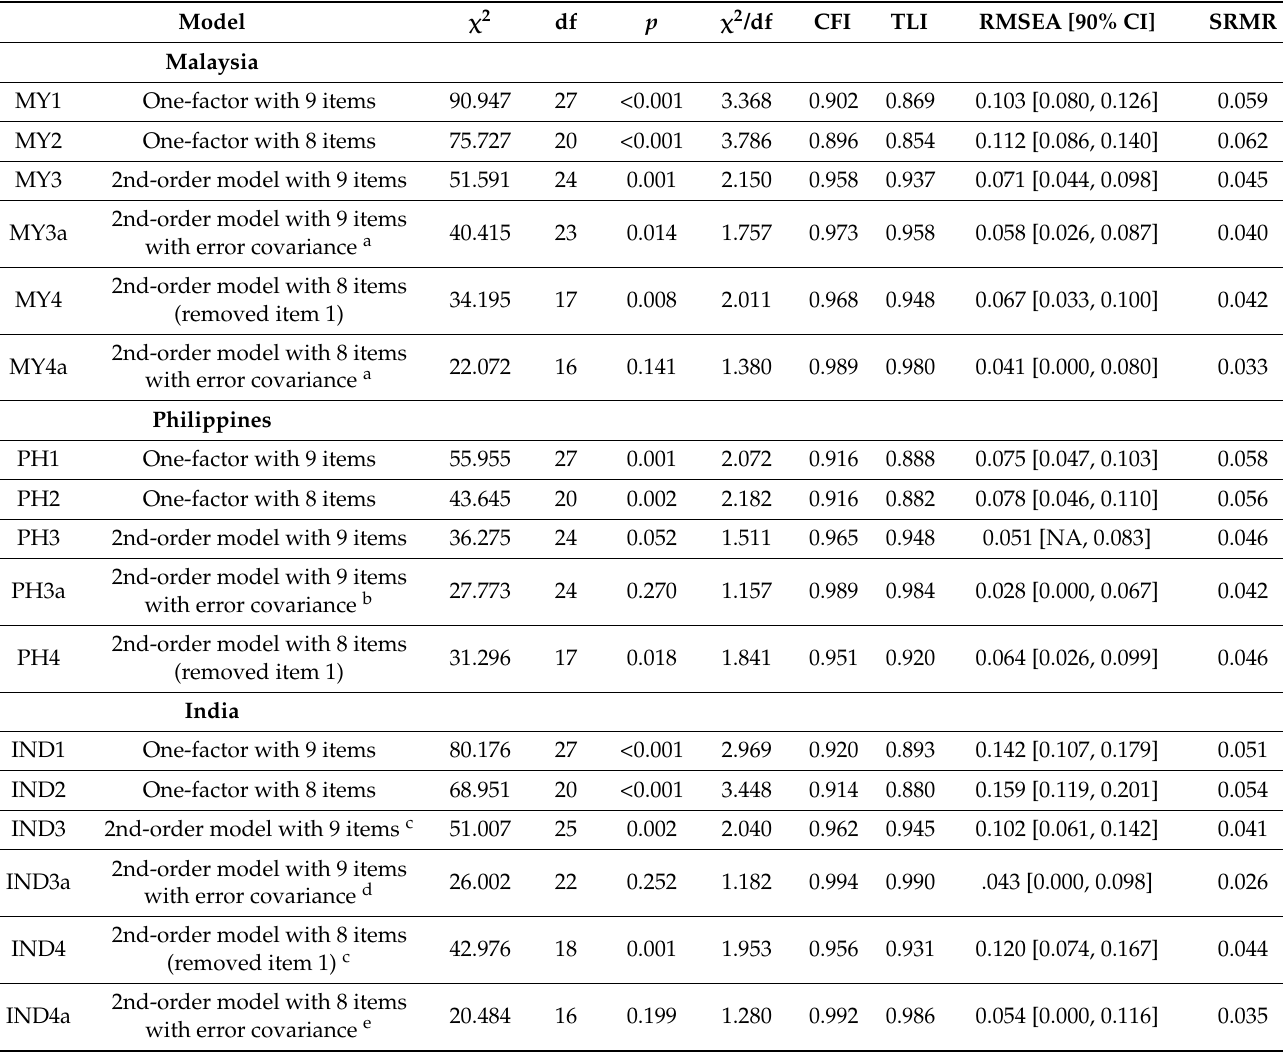
Table 1. The Fit Indices for the Models of the Interdependent Happiness